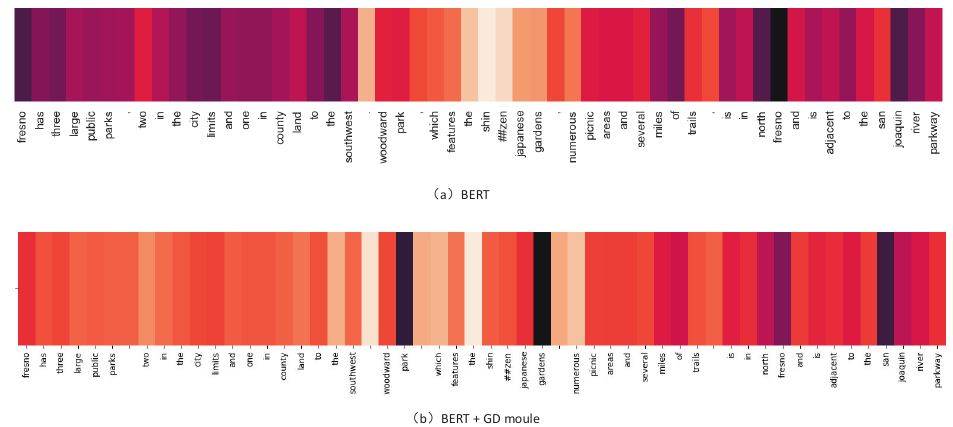
Figure 8. Effectiveness analysis. The darker the color of the token, the greater the influence of the